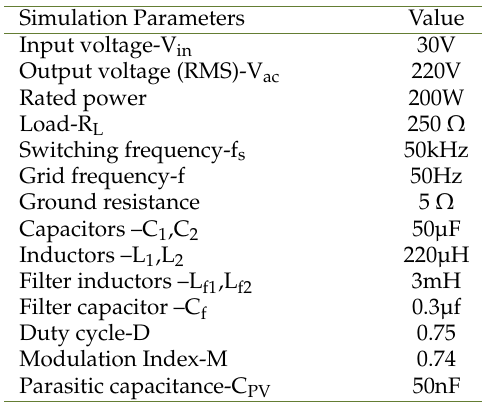
Table 1. Simulation